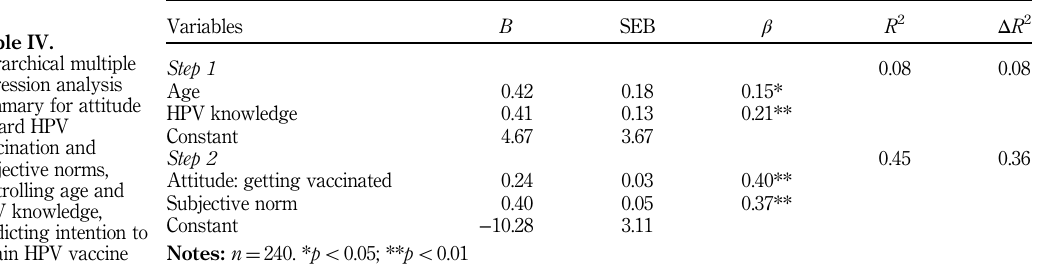
Table IV. Hierarchical multiple regression analysis summary for attitude toward HPV vaccination and subjective norms, controlling age and HPV knowledge, predicting intention to obtain HPV